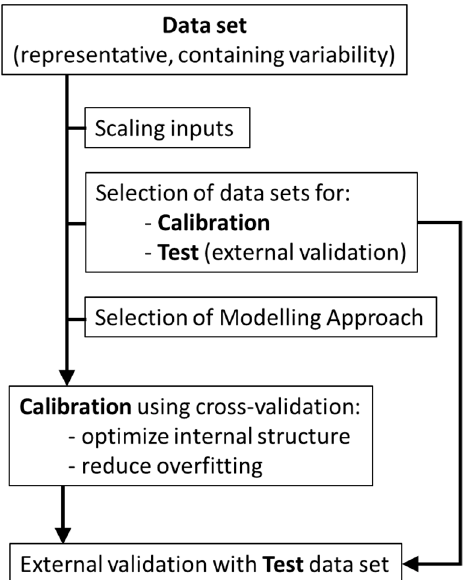
Figure 2. Diagram summarizing non-mechanistic modelling